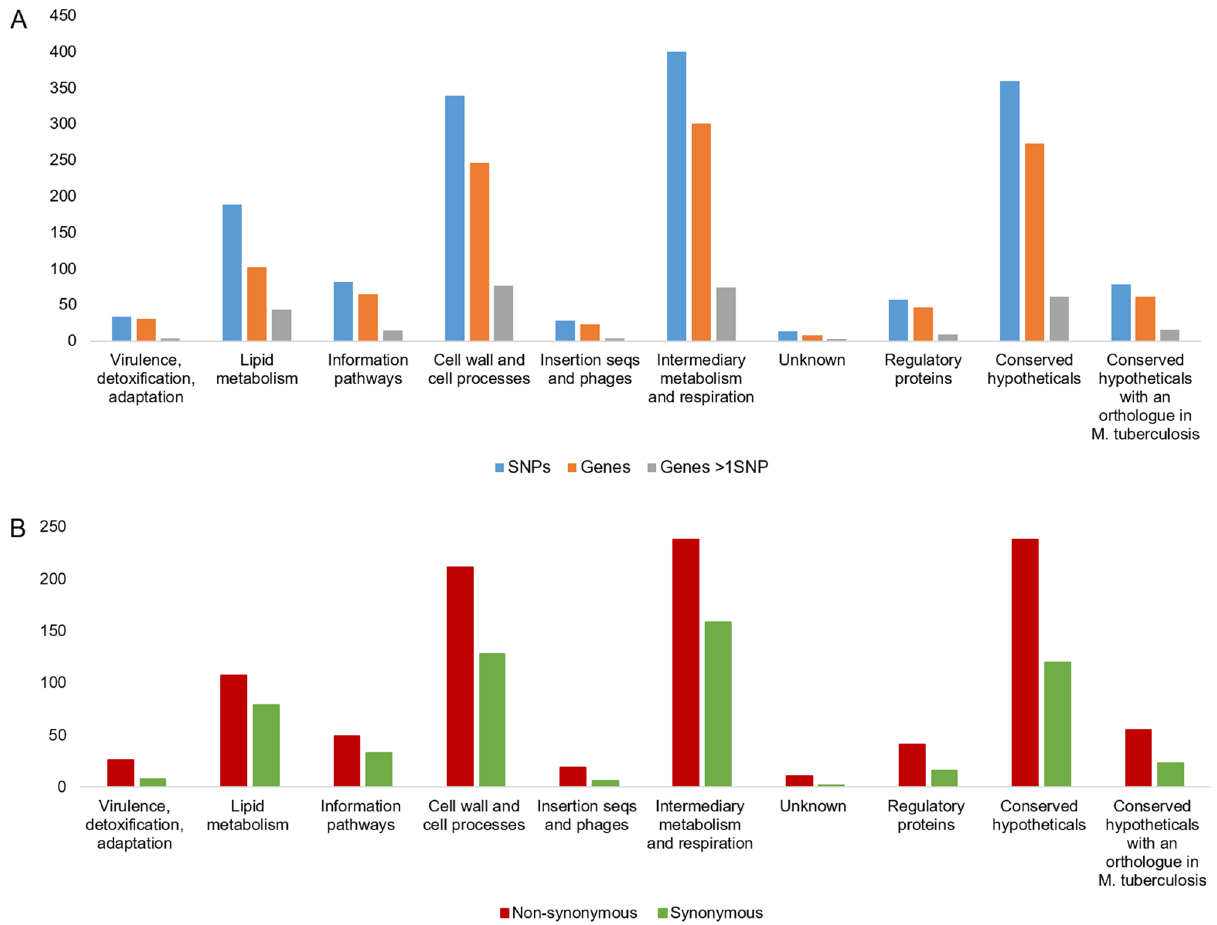
Figure 6. Stratified analysis for the M. bovis dataset from Portugal ( n = 42). Total number of SNPs and affected genes registered per functional category ( A ). Total number of synonymous and non-synonymous alterations registered by functional category ( B